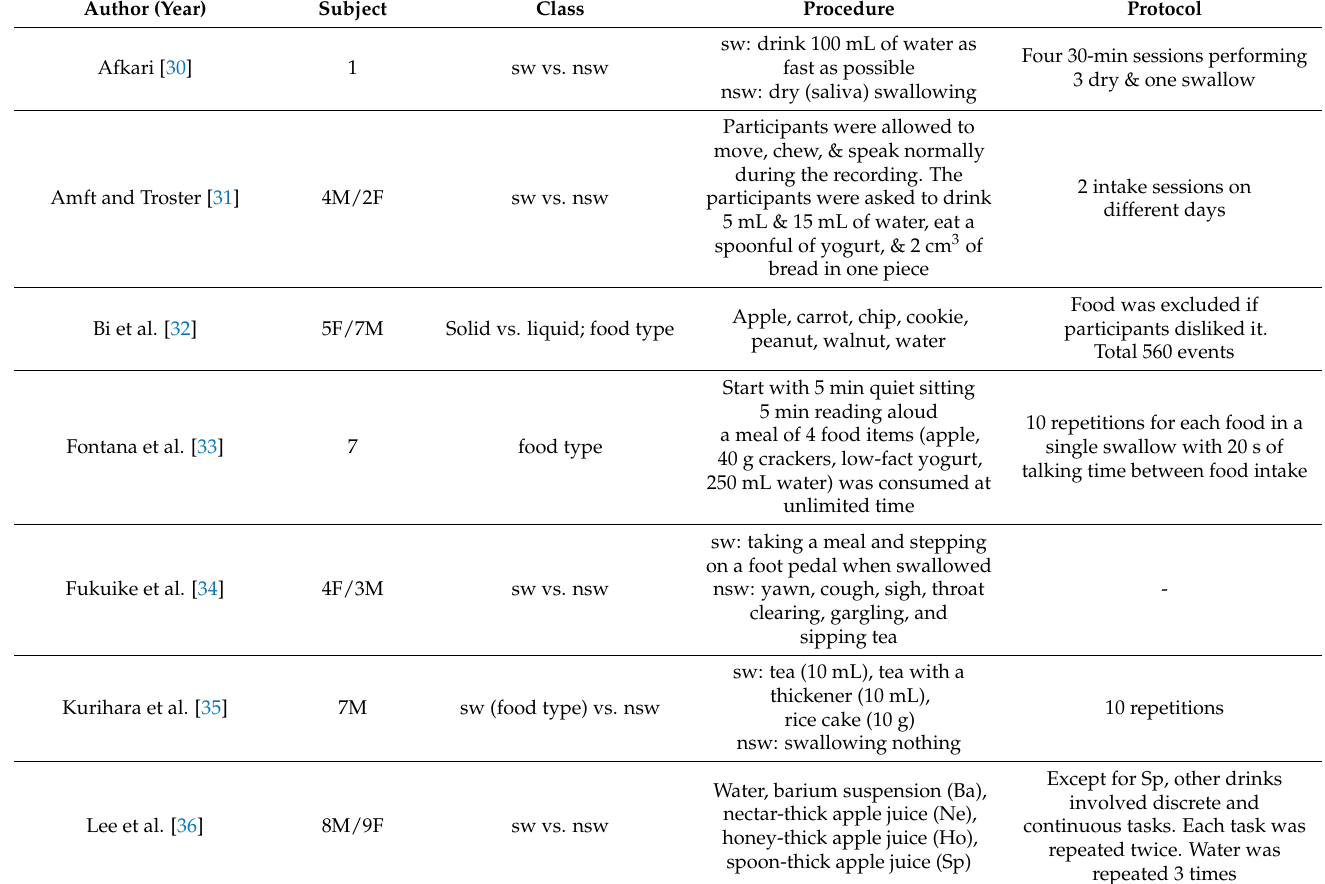
Table 2. Protocol and Procedure for Swallowing Assessment or